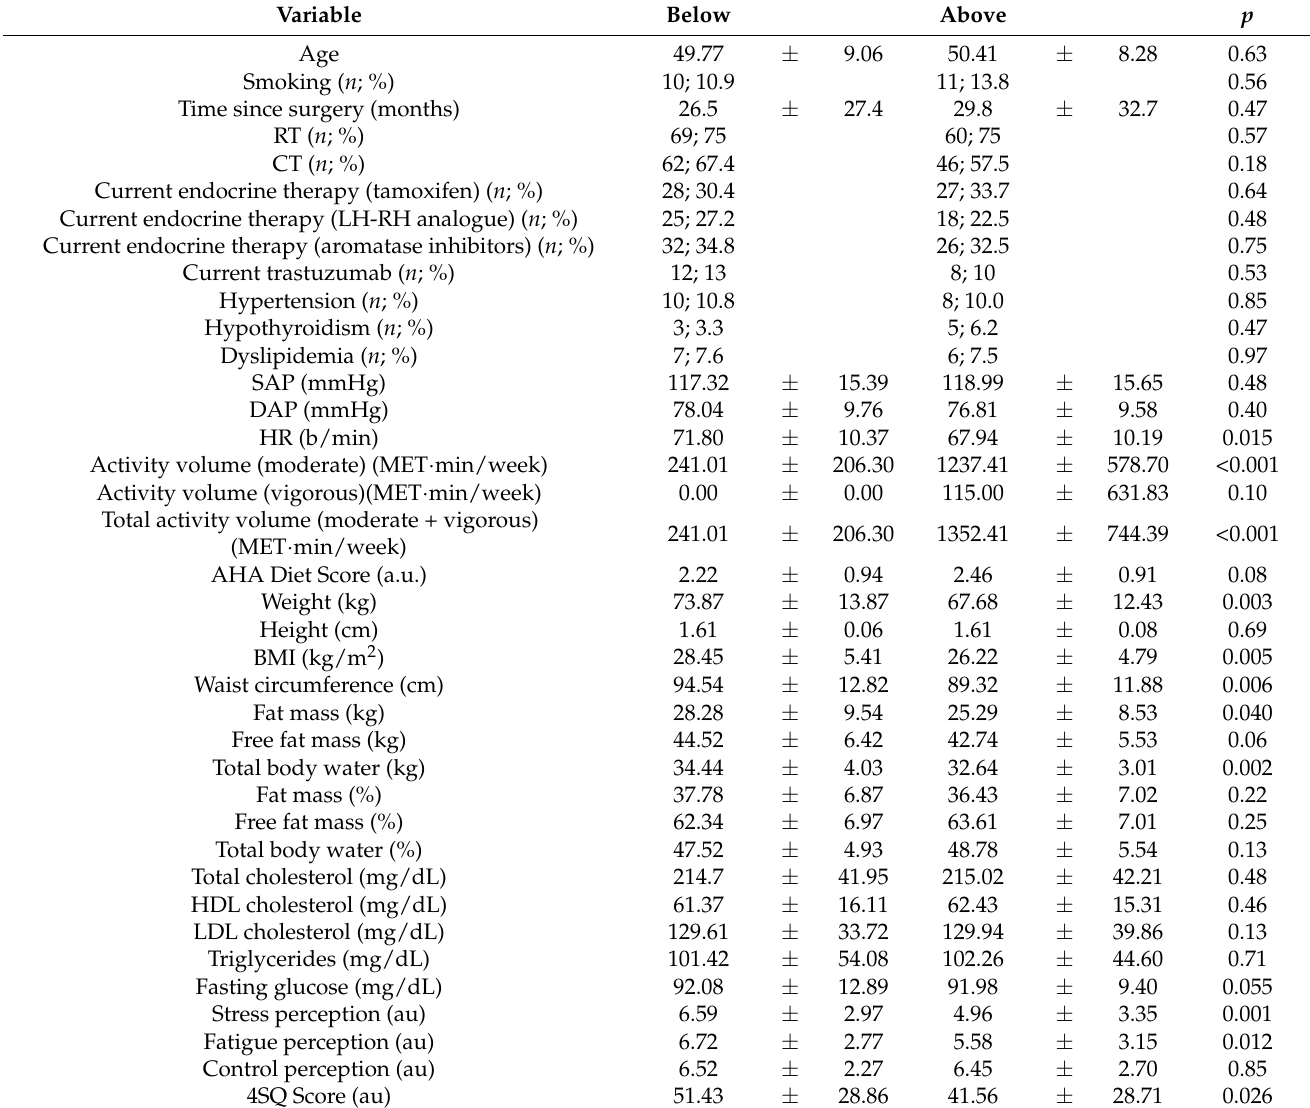
Table 1. Anthropometric, hemodynamic, metabolic and behavioural data observed in patients whose weekly physical activity was below ( n = 92) or above ( n = 80) the current physical activity